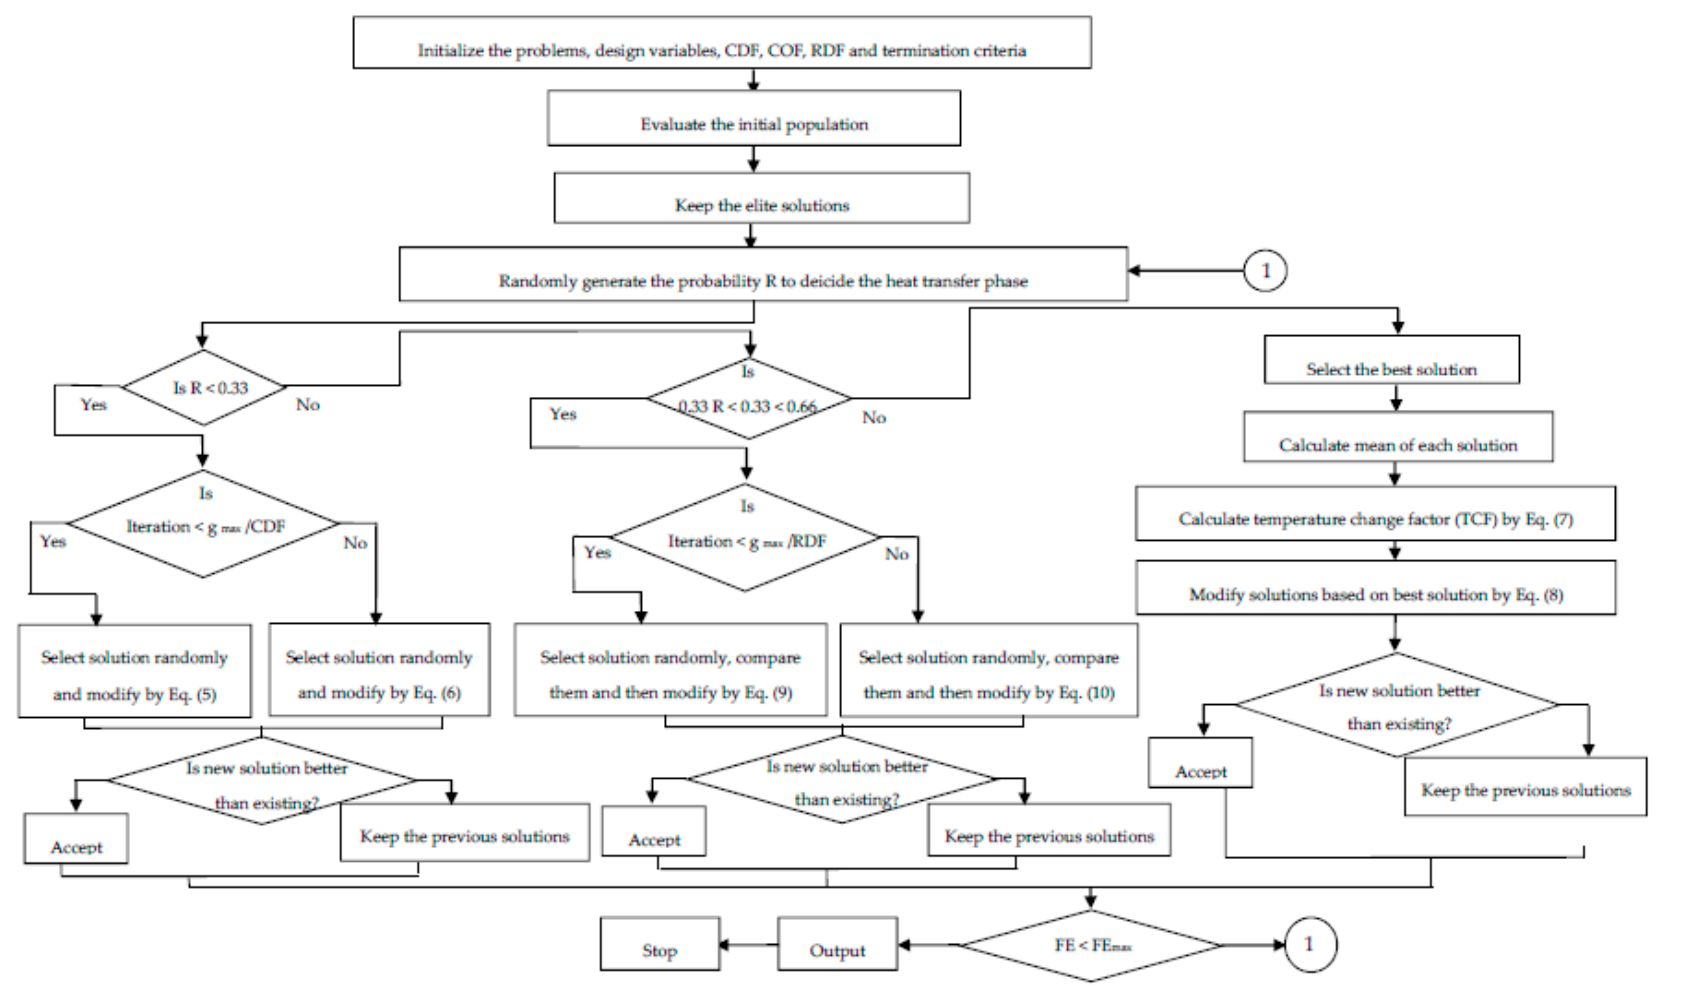
Figure 9. Flow chart of heat-transfer search (HTS) algorithm. Adapted from [31], with permission from © 2017 Elsevier.